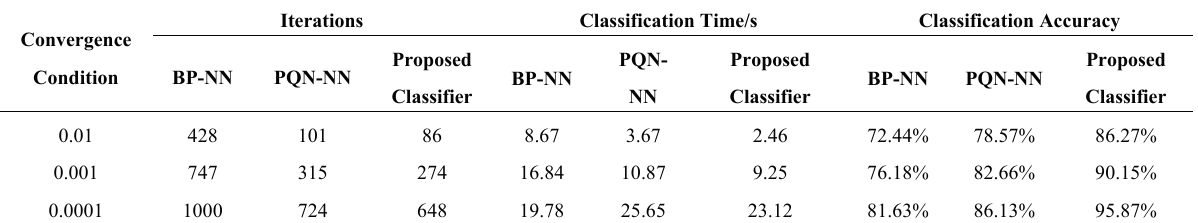
Table 9. Results obtained by different algorithms at δ =